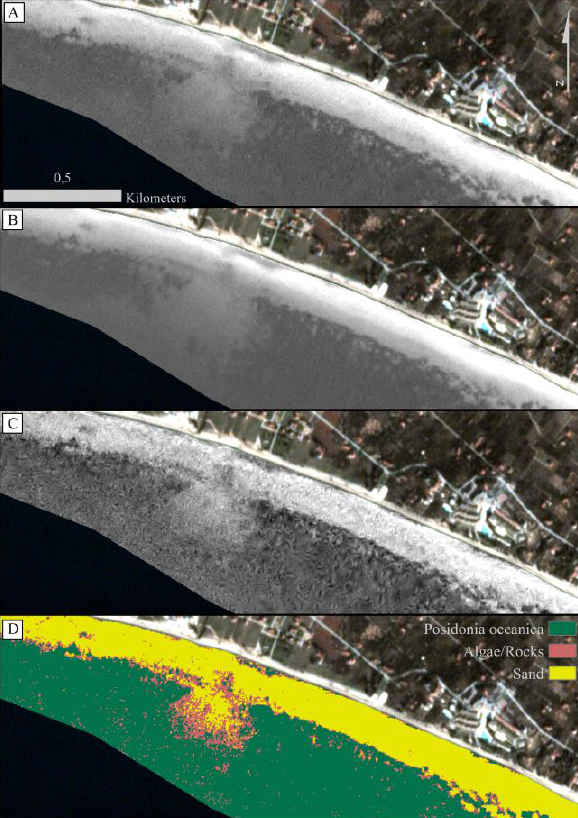
Figure 2. Experimental steps without the application of Unmixing-based denoising. A and B display the initial, ‘noisy’ blue and green Planet reflectance, respectively. C is the depth- invariant index (Lyzenga’s empirical water column correction) of A and B before applying the Unmixing-based denoising (UBD). D shows Support Vector Machine classification result of C. All rasters are draped over a PlanetScope analytic Ortho RGB Scene of 17/11/2016 over our test site in Thermaikos Gulf, NW Aegean Sea, Greece, projected in UTM (zone 34) system/WGS84.